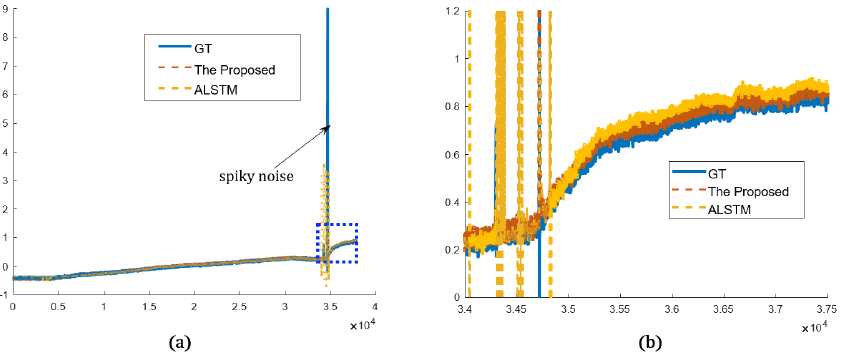
Figure 12. Prediction results in time domain (sensor B): ( a ) overview of the proposed and the best of other methods compared to the GT; ( b ) detailed view of the blue dotted rectangle of ( a